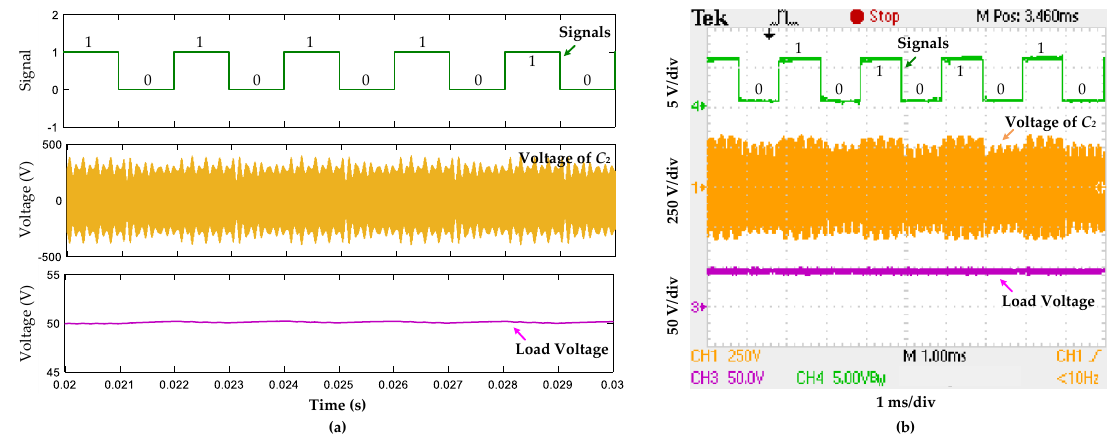
Figure 14. Data forward transmission waveforms at 1 kbit / s rate ( a ) simulation result ( b ) experimental results.